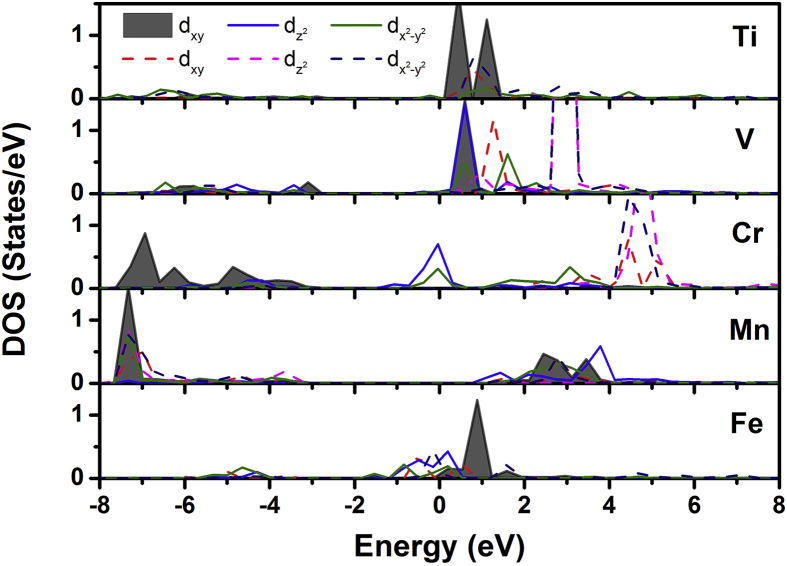
Orbital-resolved density of states of the individual TM (TM = Ti, V, Cr, Mn and Fe) d for TMO5 bipyramids in YMn0.917TM0.083O3(001)/MgO(001) configurations as a function of energy (E-EF), in which EF is the Fermi energy. Solid and dashed lines denote majority and minority states, respectively.